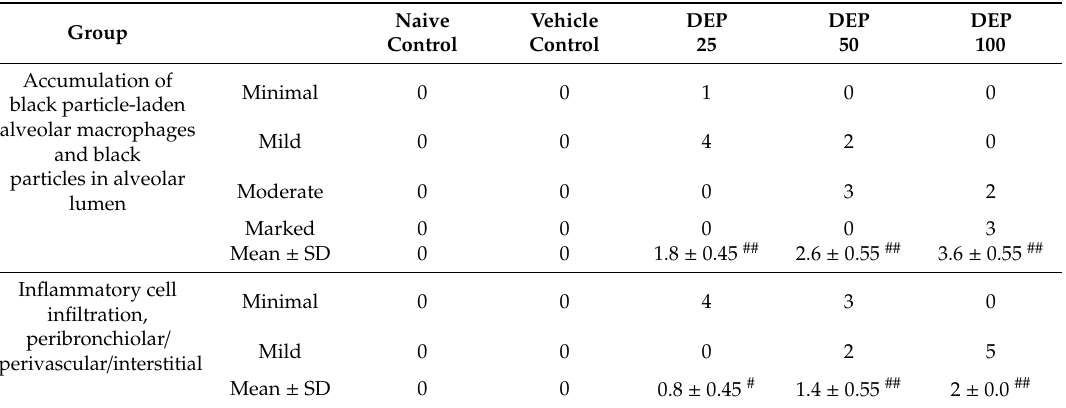
Data are means ± SD for five mice per group. DEP, diesel exhaust particulate. # p < 0.05 or ## p < 0.001 vs. vehicle control.